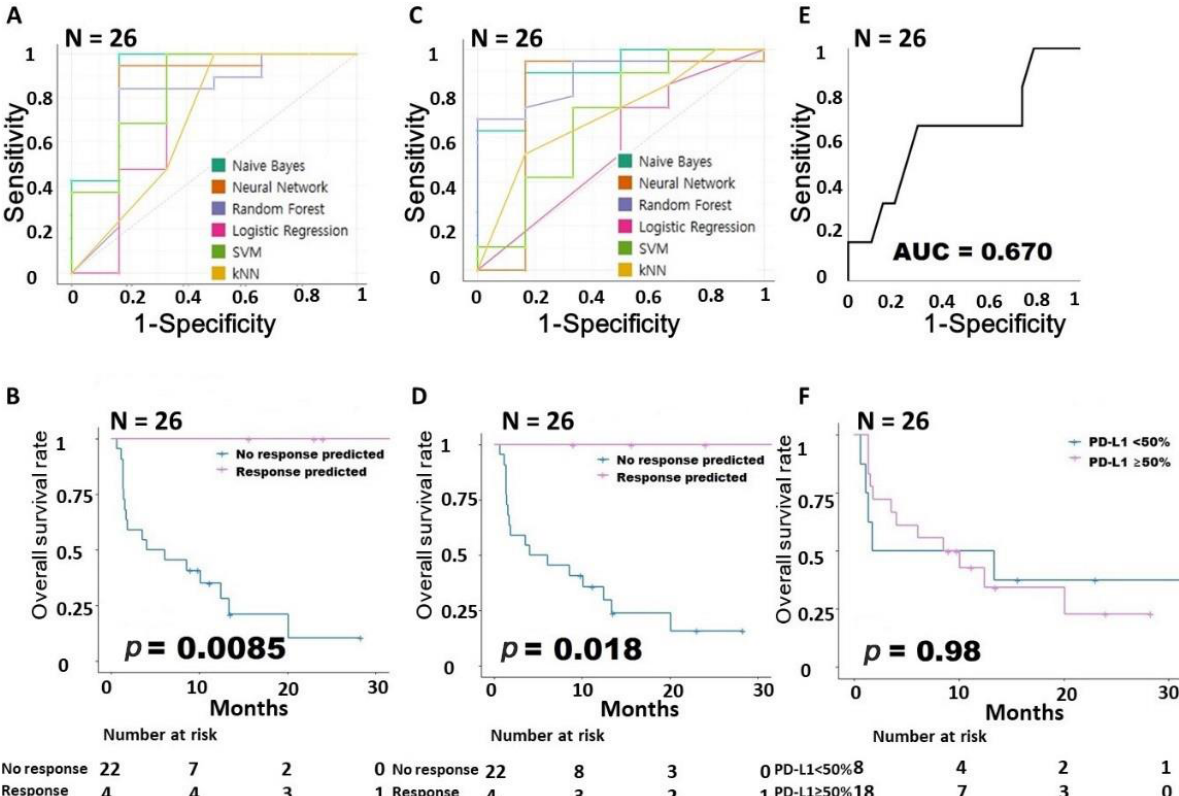
Figure 3. Building a predictive model for responsiveness to PD-1 inhibitors in LUSC. ( A ) Comparison of the AUCs for the intrinsic gene signature according to six machine learning models. ( B ) Survival analysis according to the intrinsic gene signature. ( C ) Comparison of the AUCs for the extrinsic gene signature according to six machine learning models. ( D ) Survival analysis according to the extrinsic gene signature. ( E ) AUC according to PD-L1 expression. ( F ) Survival analysis according to PD-L1 expression. AUC, area under the ROC curve; LUSC, lung squamous cell carcinoma; PD-1, programmed cell death protein 1; PD-L1, programmed cell death-ligand 1.